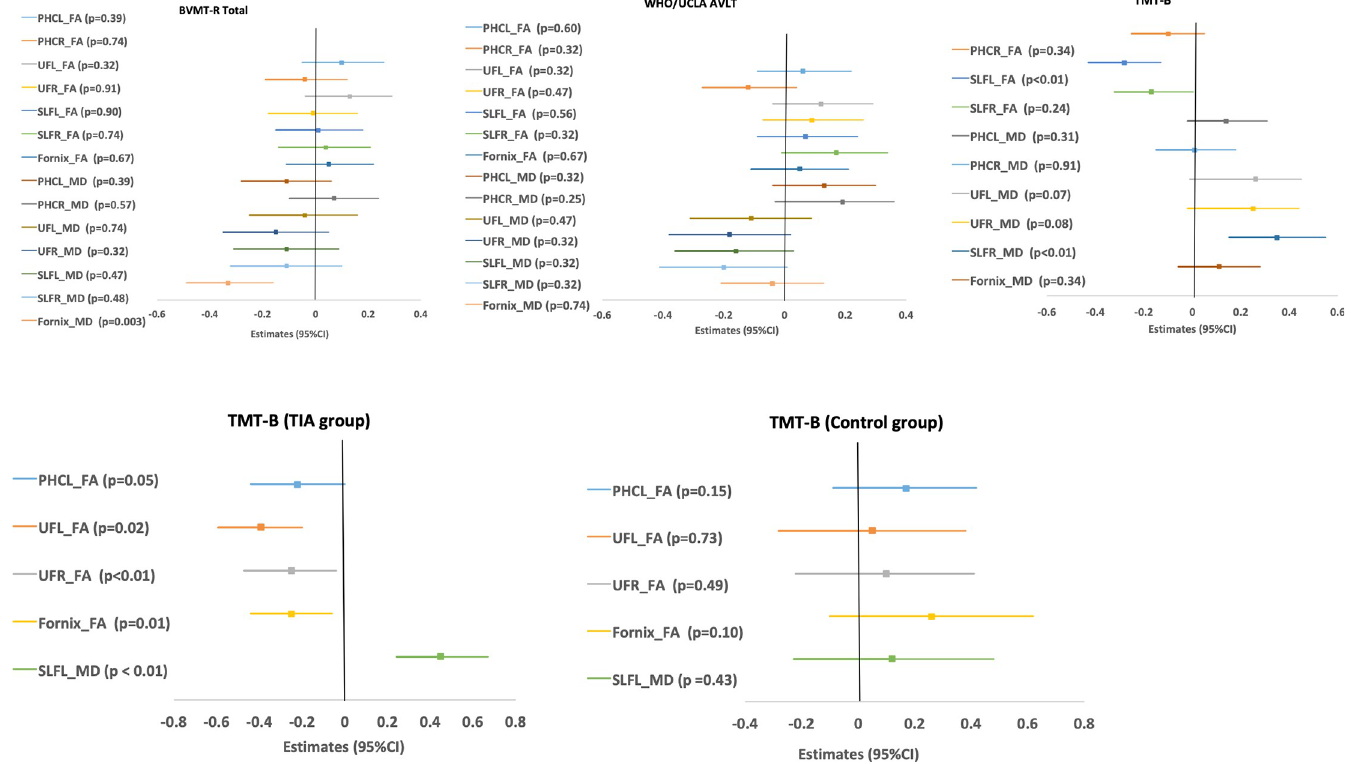
Fig 2. (A) Forest plots of the point estimates and 95% confidence interval (CI) for the relationship between DTI tracts and cognitive tests (TIA or non-TIA did not modify the relationships). Notes: The adjusted covariates include age, sex, premorbid intellect, group (TIA or non-TIA subjects), and WM hyperintensities volume. BVMT-R = Brief Visuospatial Memory Test-Revised; WHO/UCLA-AVLT: WHO/UCLA Auditory Verbal Learning Test; TMT-B: Trails Making Test. PHCL = parahippocampus, left; PHCR = parahippocampal cingulum, right; UFL = uncinate fasciculus, left; UFR = uncinate fasciculus, right; SLFL = superior longitudinal fasciculus, left; SLFR = superior longitudinal fasciculus, right. For BVMT-R total and WHO/UCLA AVLT related regressions. (B) Forest plots of the point estimates and 95% confidence interval (CI) for the relationship between DTI tracts and cognitive tests (TIA group modified the relationships). Notes: Results presented were based on multiple linear regressions where two-way interactions were significant statistically. The adjusted covariates including age, sex, premorbid intellect, group (TIA or non-TIA), and WM hyperintensities volume. TMT-B: Trails Making Test. PHCL = parahippocampus, left; UF = uncinate fasciculus, (L for left and R for right); SLFL = superior longitudinal fasciculus,